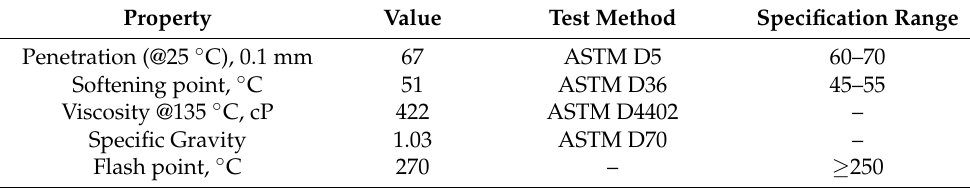
Table 2. Asphalt was purchased from Suez Petroleum Refining Company, Suez, Egypt. Table 2. Physical properties of unmodified asphalt.